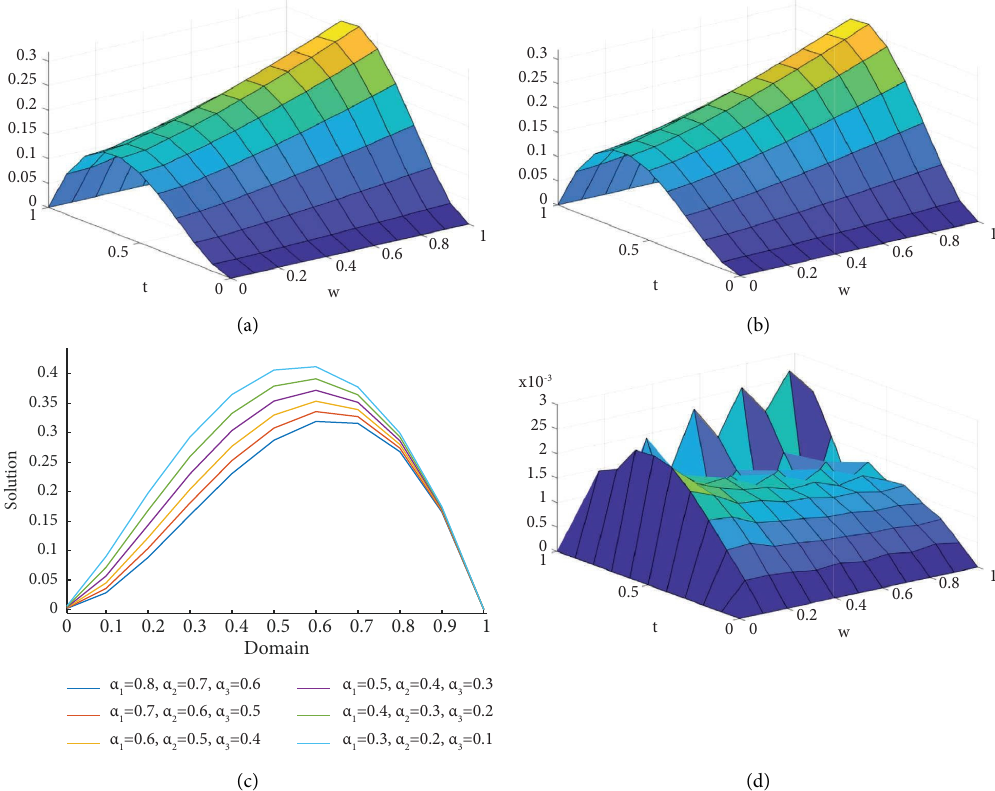
Figure 6: Graphical solution of approximate, exact, and error of Y at h � Δ t � 0 . 1 and plots at t � 1. (a) Approximate solution. (b) Exact solution. (c) Plots for diferent value of α ’s. (d)